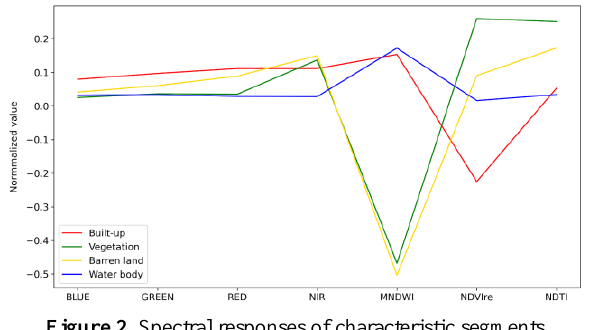
Figure 2 . Spectral responses of characteristic segments represented by the mean normalized